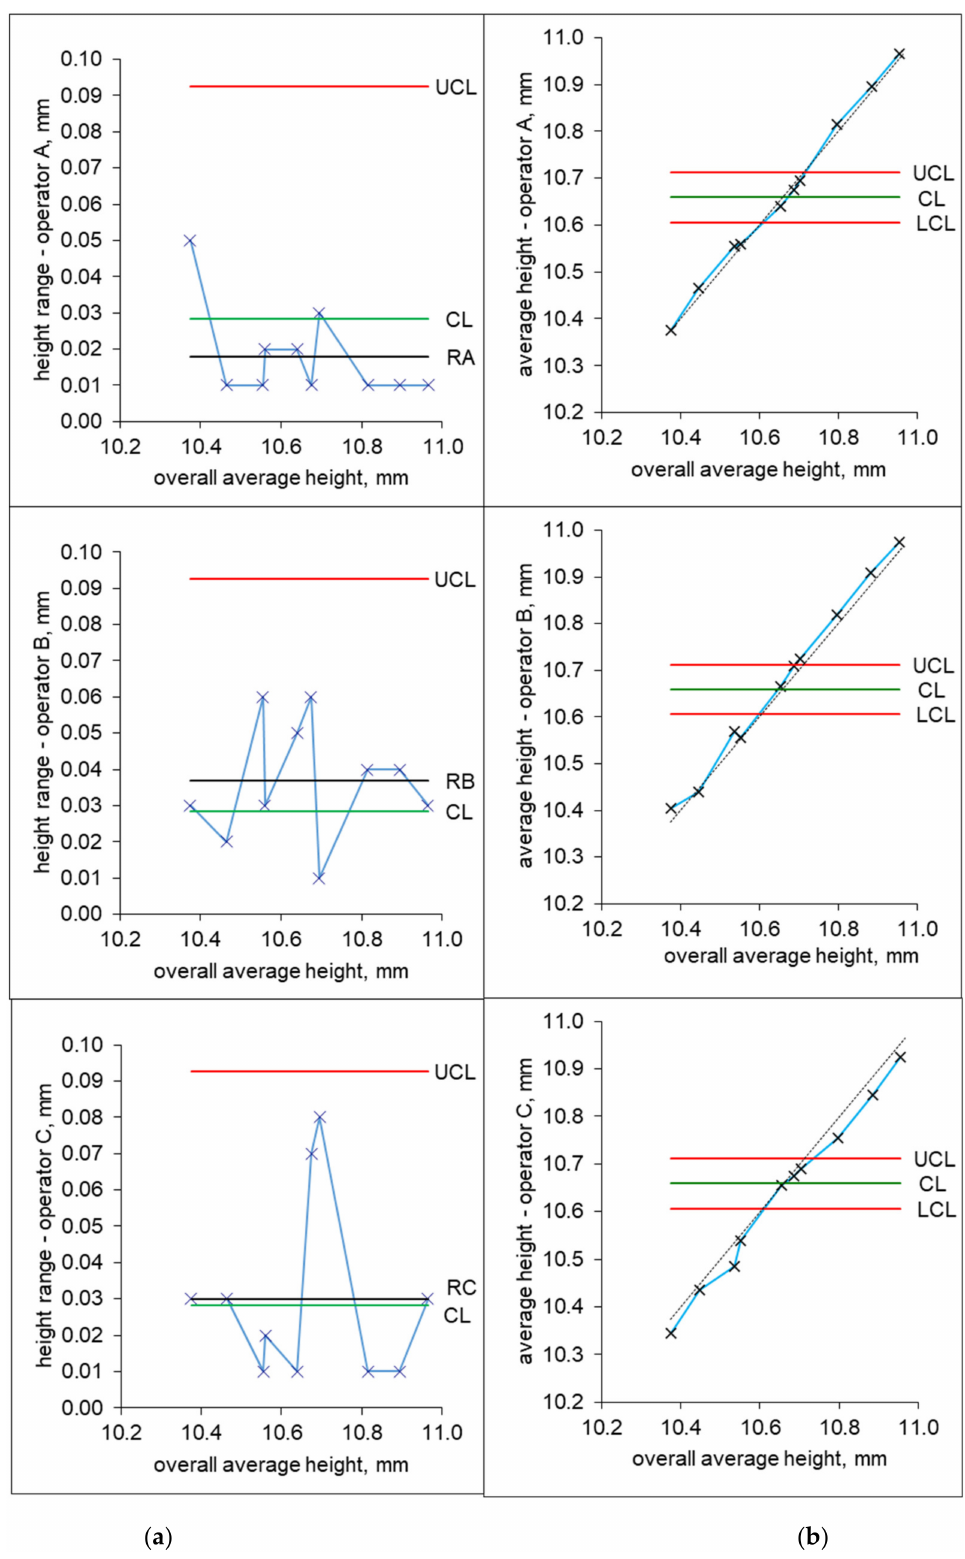
Figure 5. Range and average control charts: ( a ) range control charts; ( b ) average control charts. It can also be concluded that the variability of the repeated measurements does not depend on the magnitude of the measured value (conforming uniformity). Since the ranges of the repeated measurements fluctuate a great deal for some operators, an analysis